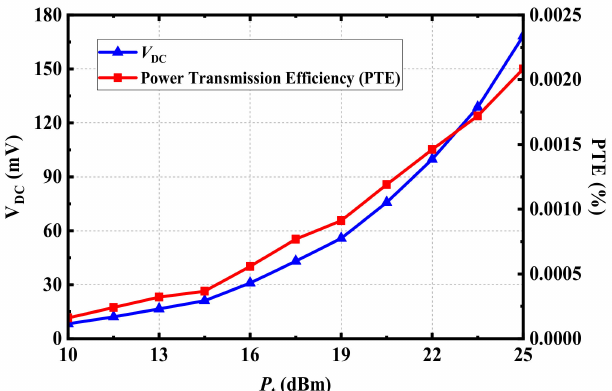
Figure 19. Measured output DC voltage and power transmission efficiency of the proposed rectenna at 915